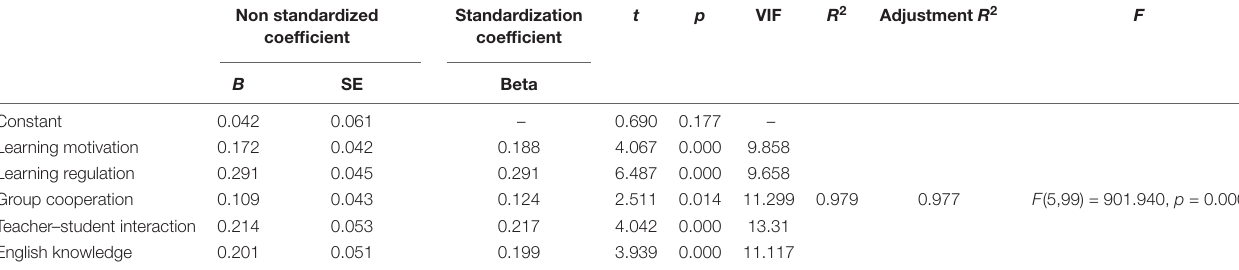
TABLE 2 | Stepwise regression results of factors influencing behavioral engagement of English